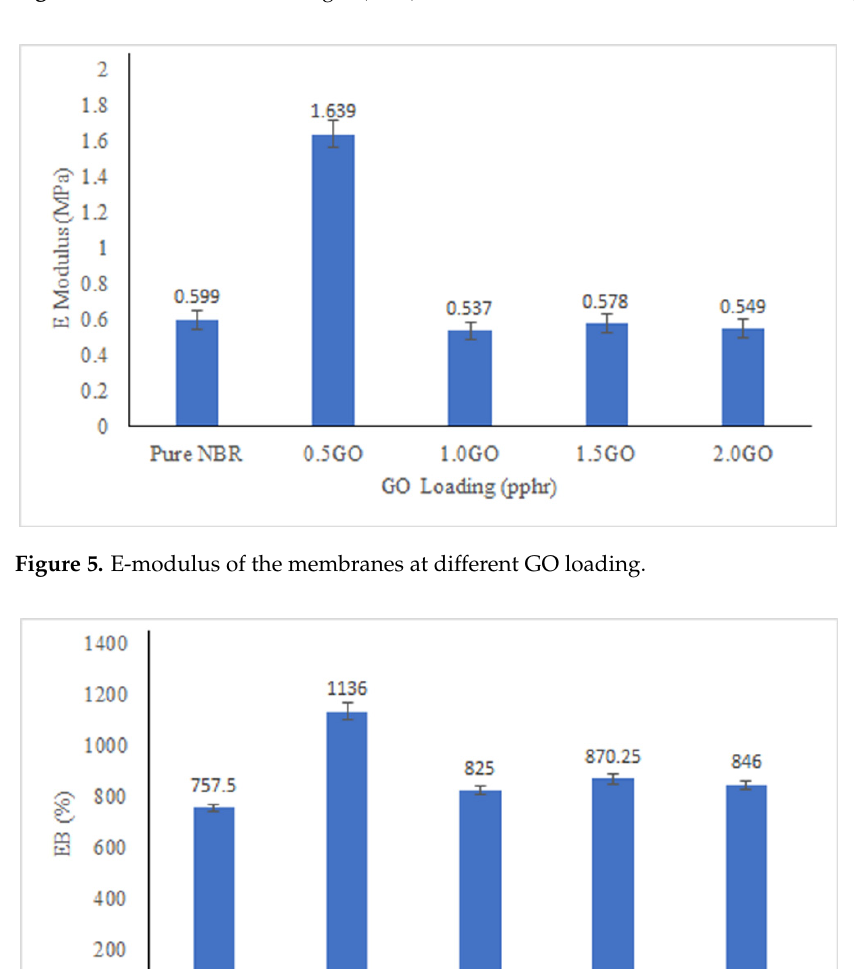
Figure 4. Ultimate tensile strength (UTS) of the membranes with different GO loading.